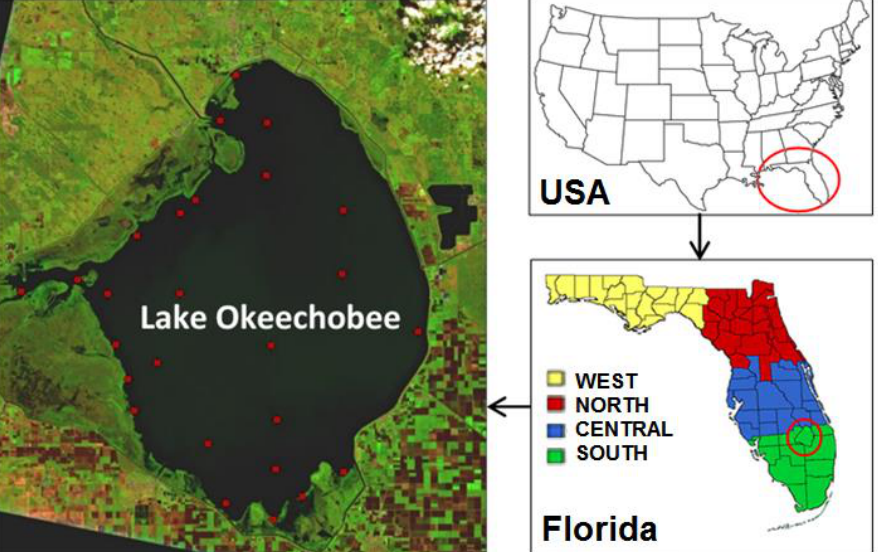
Figure 1. Study area and the water quality monitoring